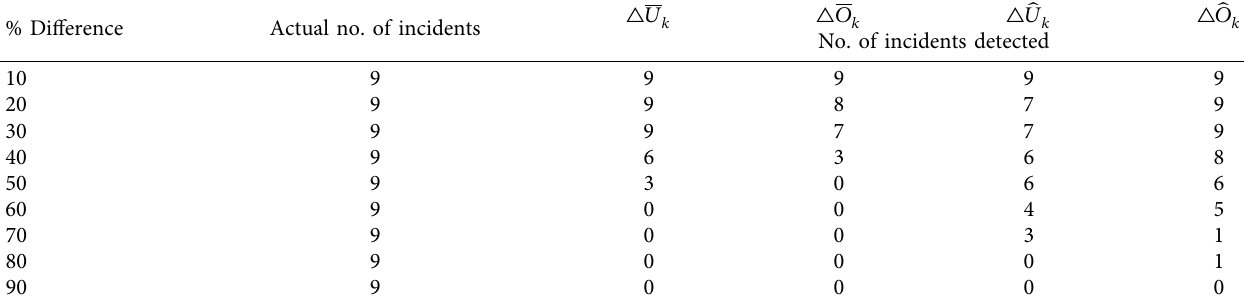
Table 3: Incident detection at different intervals of percentage difference in speeds and occupancies. % Difference